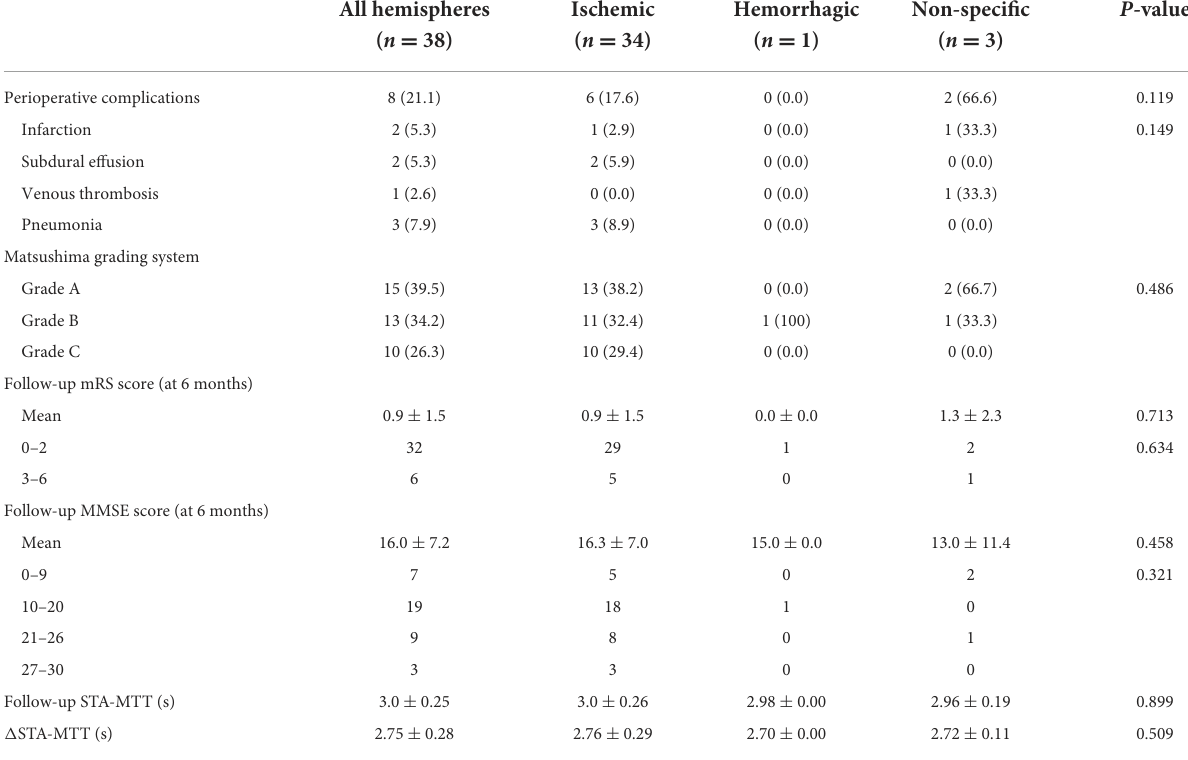
TABLE 2 Angiographic outcomes, neurological status and cognitive function of patients in the surgical group.